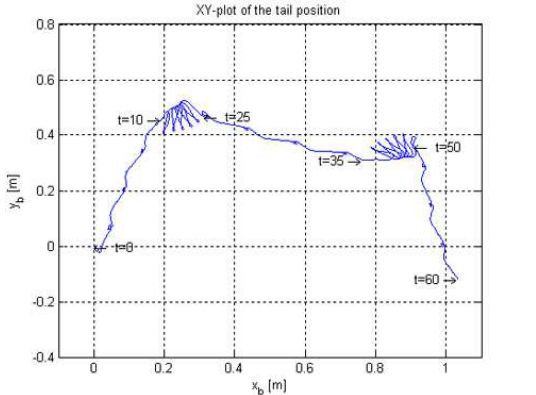
Figure 11: XY-plot of the tail position of the snake in the base-frame for the simulated gait pat- tern, sidewinding.